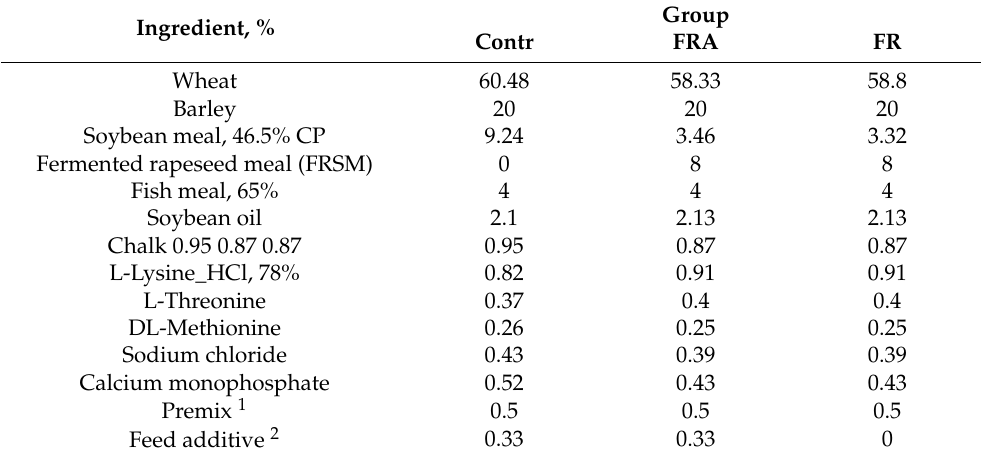
Table 1. Ingredient composition (% of air-dried matter) and nutrient content of piglets’ diets [14]. Group Ingredient, % Contr